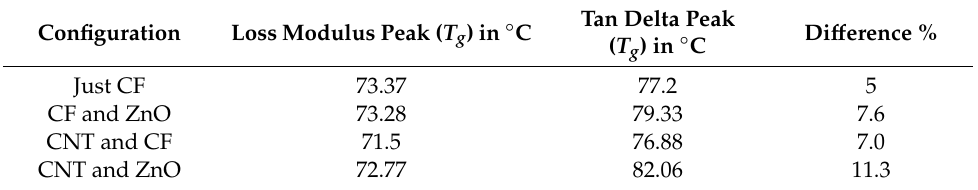
Table 1. Comparison of glass transition temperature of the di ff erent composites’ configurations.